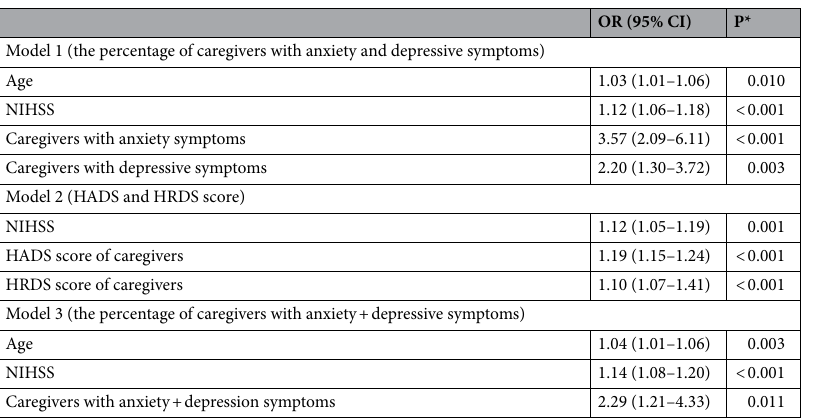
Table 6. Multivariable Models Showing Association Between risk factors and 6-month mortality. *Multivariable adjusted for age, baseline NIHSS, current alcohol drinking, the percentage of caregivers with anxiety and depressive symptoms/the percentage of caregivers with anxiety + depressive symptoms (or HADS score and HRDS score of caregivers), statin